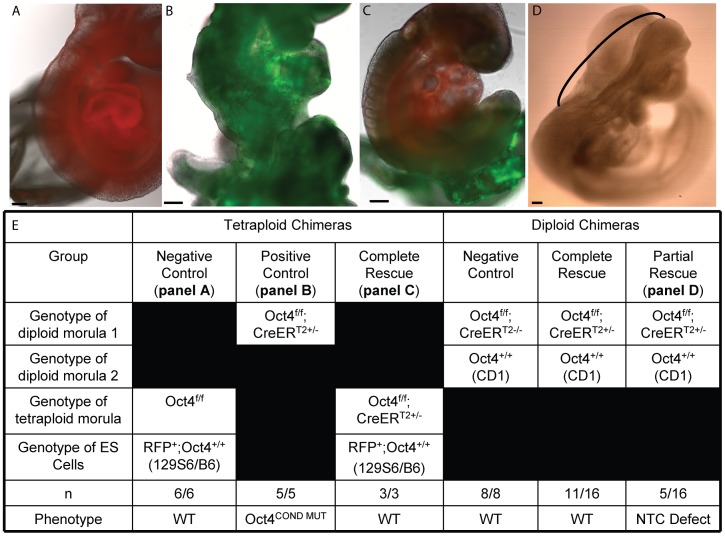
Tetraploid chimeras indicate that Oct4 is not required extraembryonically ∼E7.5, while diploid chimeras indicate that Oct4+/+ can compensate for Oct4−/− cells embryonically.All embryos transferred to a surrogate and depicted or described in panels A–E were induced with tamoxifen ∼E6.0 and ∼E6.5 to compensate for the variability in developmental timing associated with transfer (Table S1Q,AB). Scale bars in panels A–D are 200 um. A A representative embryo from aggregation of Oct4+/+ RFP ES cells with a tetraploid Oct4f/f embryo. Oct4f/f extraembryonic tissue yielded E9.5 chimeric embryos with no phenotype. B An Oct4f/f;CreERT2+/− E9.5 embryo with the Oct4COND MUT phenotype. C Oct4 depletion in extraembryonic tissue is compatible with WT development. A representative chimera consisting of RFP+ Oct4+/+ ES cell derived embryo and tetraploid Oct4f/f;CreERT2+/− extraembryonic tissue. The embryo has turned (compare panel ‘B’ where the tail is behind to panel ‘C’ where it is in front), undergone NTC and posterior extension (compare the lack of somites and short tail in panel ‘B’ to the somites and full-length tail in ‘C’). D The most severe embryonic defect observed in a diploid chimeras consisting of Oct4+/+ and Oct4f/f;CreERT2+/− cells. The neural tube is open between closure points 1 and 2, indicated here with a black bracket. All Oct4COND MUT features aside from cranial NTC defect, which is still present in 5/16 mosaic embryos, are rescued by Oct4+/+ cells in these diploid chimeras (16/16). For example, this embryo has ‘turned’ such that it faces its tail and the posterior has extended normally. E Quantification of the genotypes and phenotypes of recovered chimeric embryos.